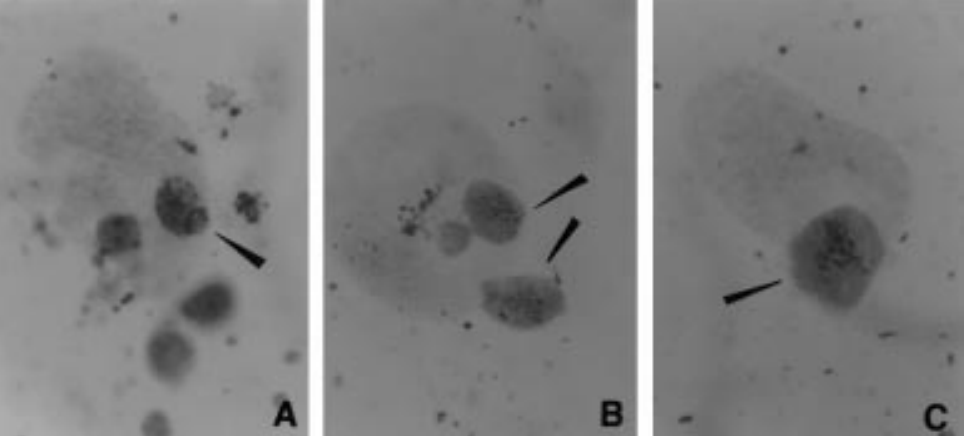
Fig. 2. AgNOR expression in micronuclei. A – AgNOR dots within an outline of a micronucleus. B – tiny AgNOR dots in the nucleoplasm of the micronucleus. C – strong AgNOR expression in the nucleolar region of the micronucleus. Arrows point to the developing micronuclei. NOR proteins were stained with silver nitrate, DNA was stained by Feulgen procedure. Obj. 90 (cid:2) , oc. 7 (cid:2) .